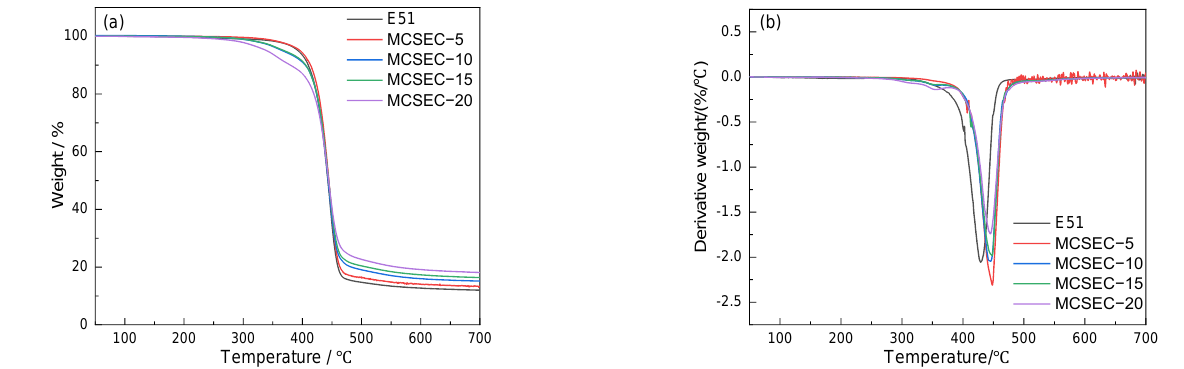
Figure 6. ( a ) TG; ( b ) DTG curves of MCSEC with different contents.